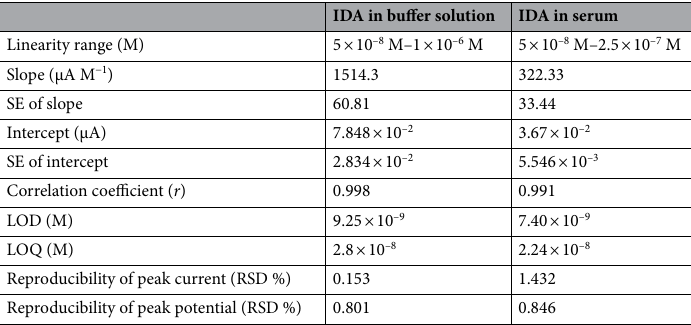
Table 2. Regression data of the calibration graphs for IDA on Ru@VC/GCE.